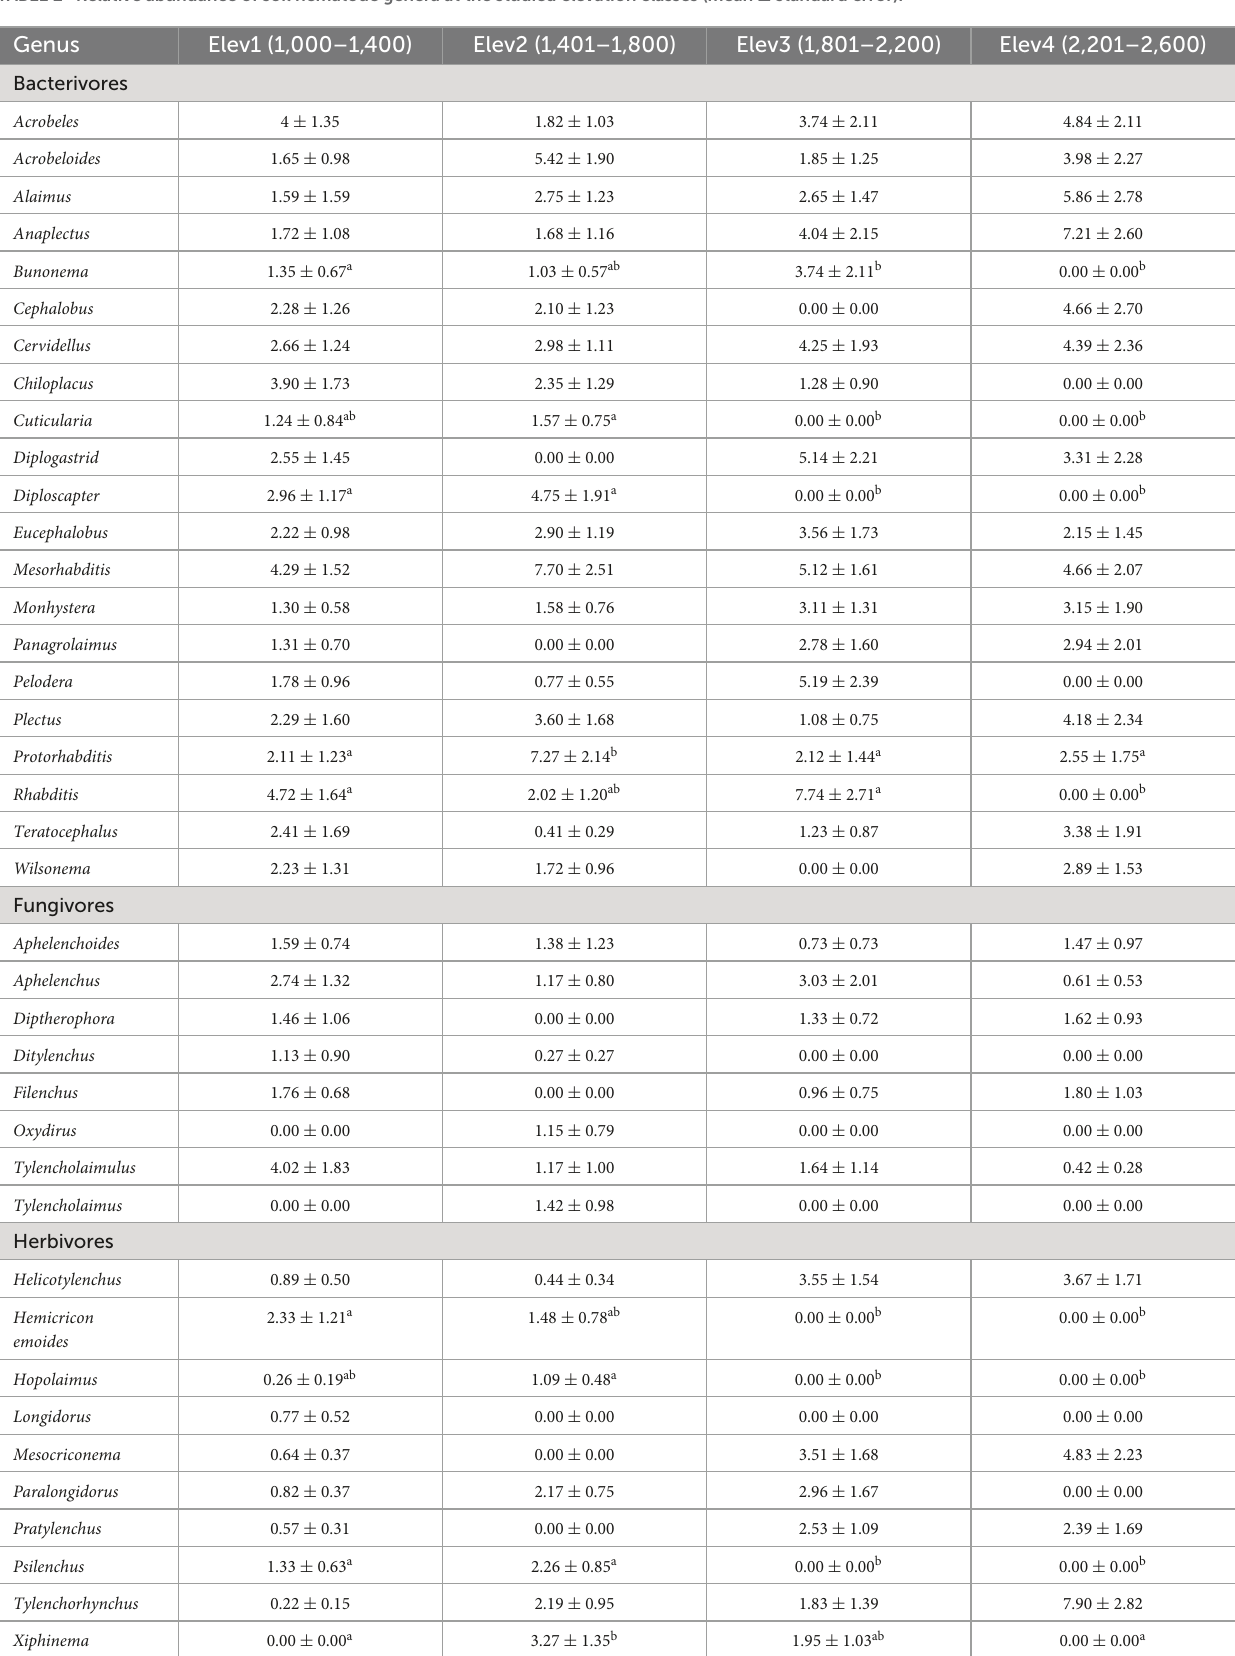
TABLE 2 Relative abundance of soil nematode genera at the studied elevation classes (mean ± standard